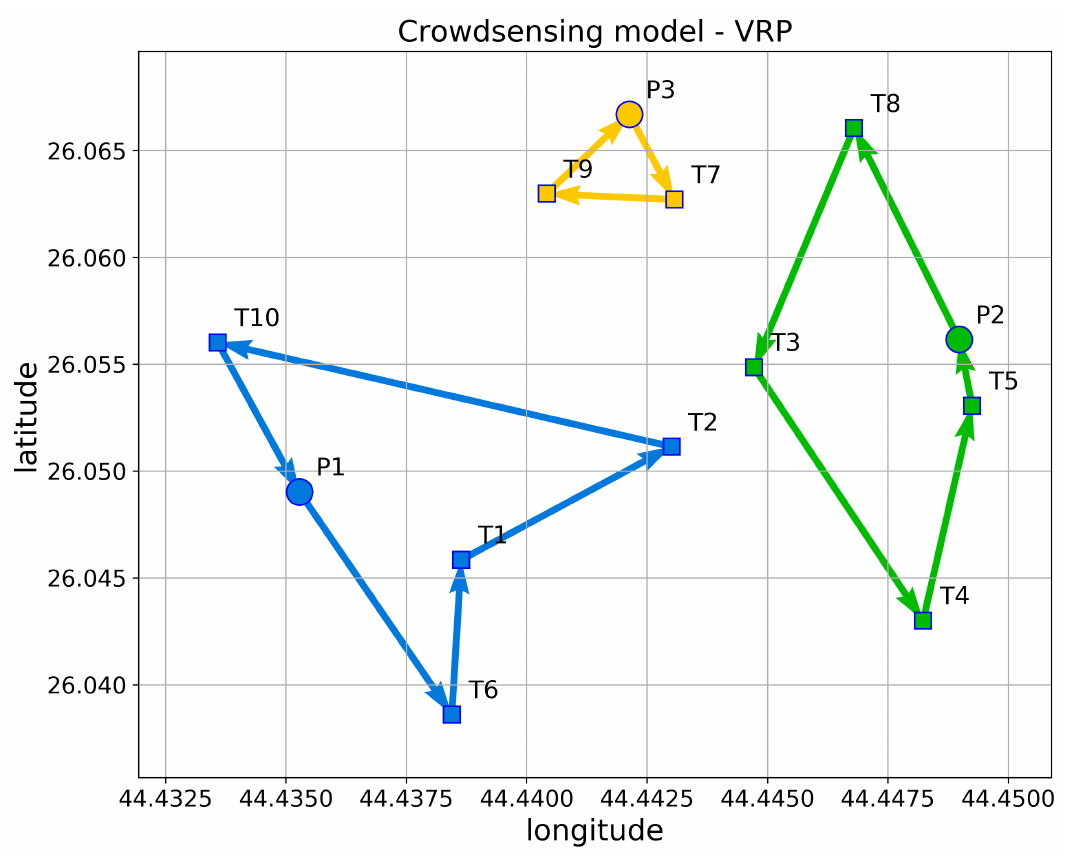
Figure 8. Crowdsensing model with Vehicle Routing Problem (VRP) solution.